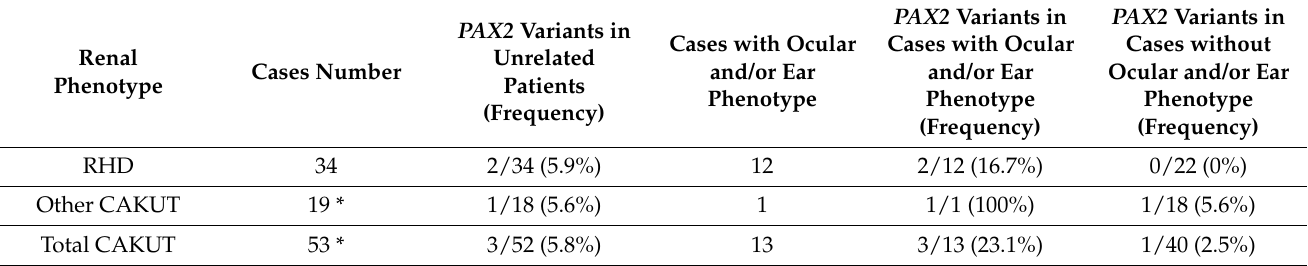
Table 3. PAX2 variants distribution by renal phenotypes of the pediatric